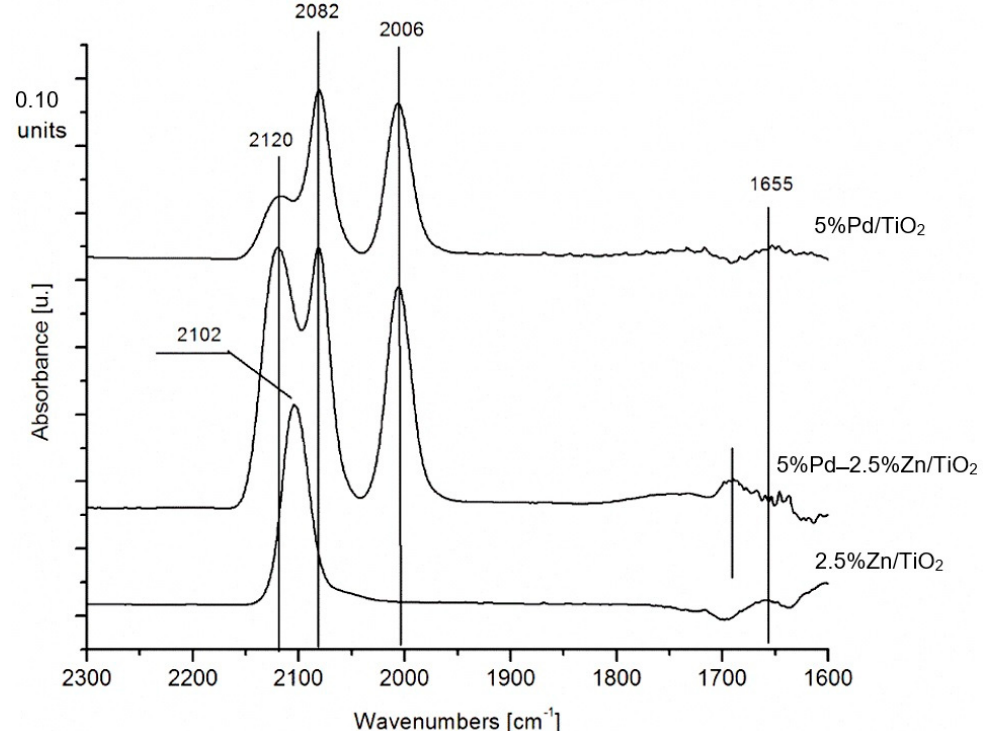
Figure 5. FTIR spectra of carbon monoxide adsorbed on bimetallic and monometallic catalysts, after reduction at 100 °C in H 2 for 0.5 h, purging with Ar at 40 °C for 0.5 h, and CO sorption at 40 °C with flow of 10 mL·min − 1 . The IR spectra were collected at the same temperature after CO desorption in an Ar stream (30 mL·min − 1 ) for 20 min.